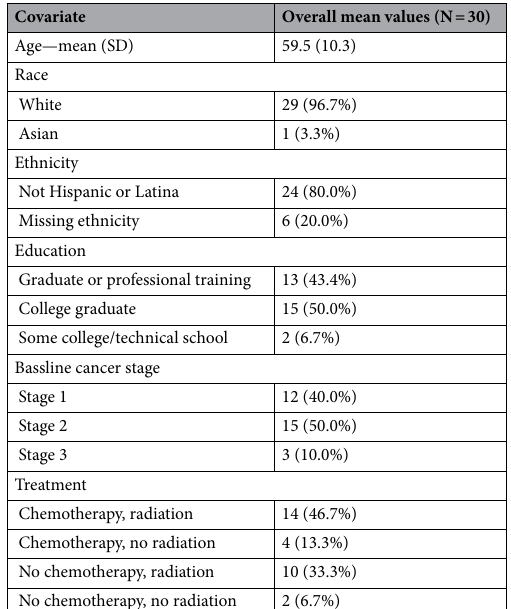
Table 1. Of the participants, 46.7% (n = 14) had received both chemotherapy and radiation treatments, 33.3% (n = 10) had received only radiation treatment, 13.3% (n = 4) had received only chemotherapy treatment, and 6.7% (n = 2) had received neither chemotherapy nor radiation treatment. The average age of the subjects was 59.0 (SD = 10.5) years. Of the participants, 96.8% (n = 30) were white, and 93.5% (n = 29) had completed either college or graduate/professional training. All participants were postmenopausal women with estrogen positive breast cancer. They had a baseline cancer stage 1 (n = 12), stage 2 (n = 15), or stage 3 (n = 3). Average EndoPAT ratio, psychosocial stress measure scores, inflammatory biomarker concentrations, and senescence biomarker concentrations for the study population as a whole are displayed in Table 2. The EndoPAT ratio (mean of 0.60) was low in all participants where low EndoPAT ratios (< 1.6) were previously associated with worsening endothelial function and increased CV risk 5 . Mean scores from the PHQ, GAD, and PSS assessments